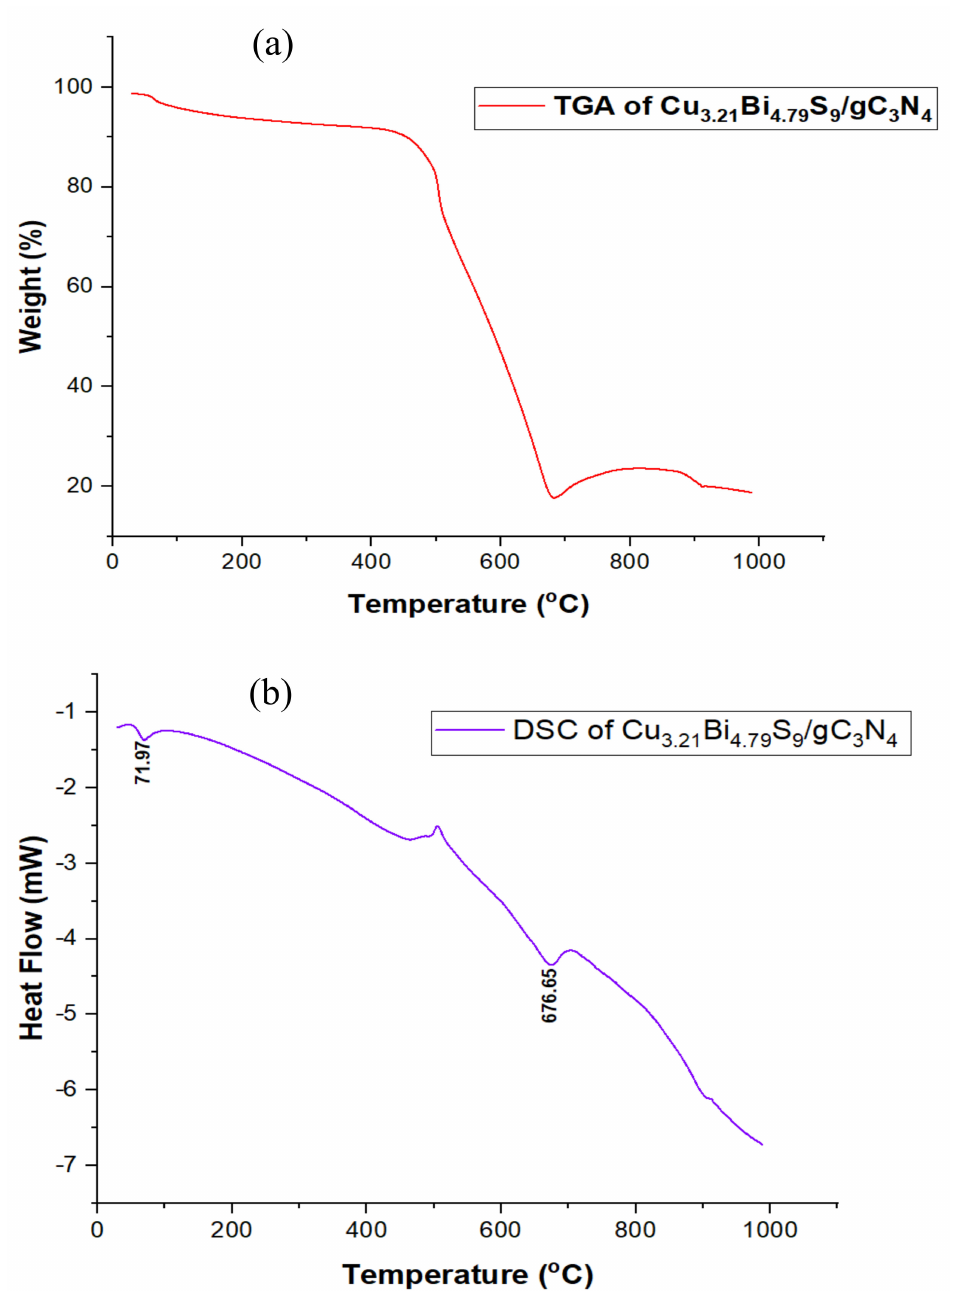
Figure 6. ( a ) TGA and ( b ) DSC of Cu 3.21 Bi 4.79 S 9 /gC 3 N 4 under nitrogen gas. TGA shows the thermal stability of the nanocomposite while DSC shows the thermal